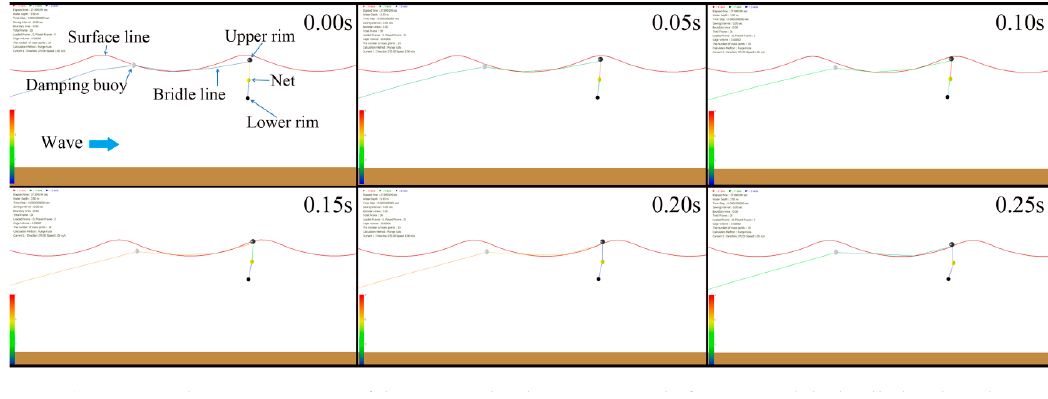
Figure 10. A dynamic response of the cage under the wave period of 1.291 s and the bridle-line length of 2.4 m.